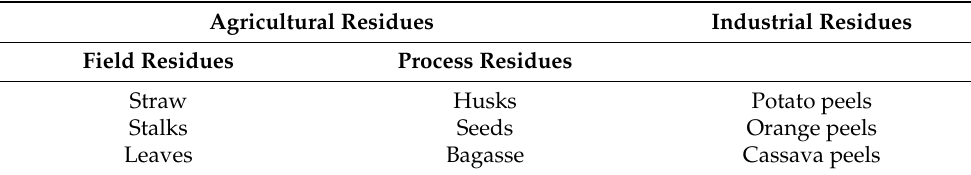
Table 3. Examples of fermentable agro-industrial